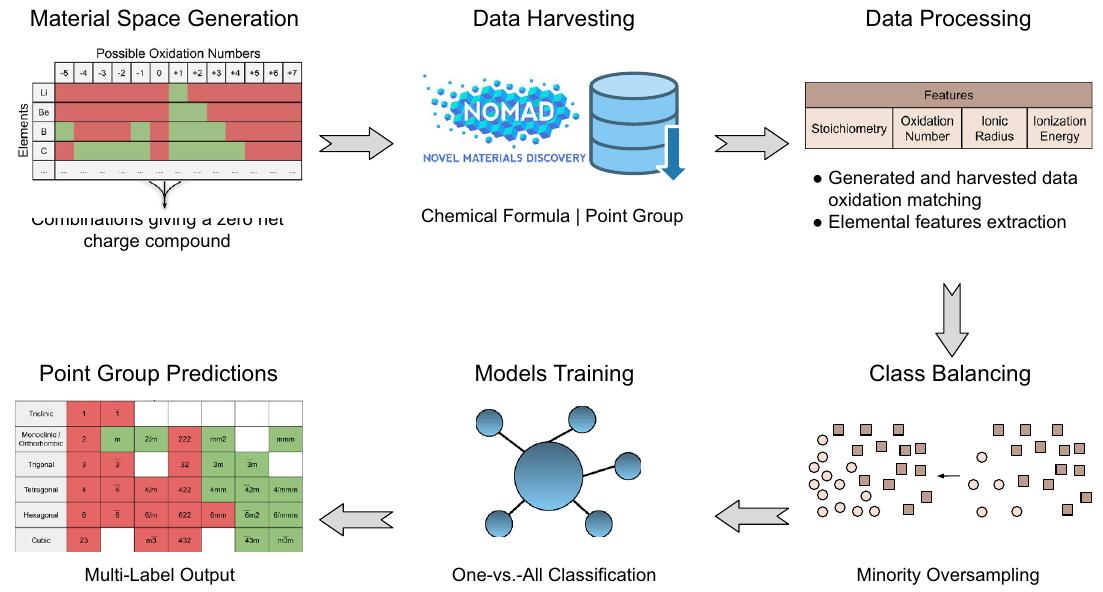
Figure 1. The generic workflow of point group classification from the chemical formula. It starts from the generation of the material space based on the common and uncommon oxidation states of the constituent elements. All elements of the periodic table till atomic number 85 are considered except H, Au, Pt, and noble gases. Then, the material space is matched with the harvested structural data from the open access NOMAD repository 48 . After that, the coefficient, oxidation number, ionic radius and the first ionization energy of each constituent element are processed as features for learning purposes. Next, the influence of imbalance distribution of data is mitigated using minority oversampling. Then, the model is trained using one-vs-rest classifier. Finally, the point groups of the chemical formulae are predicted which can possess more than one